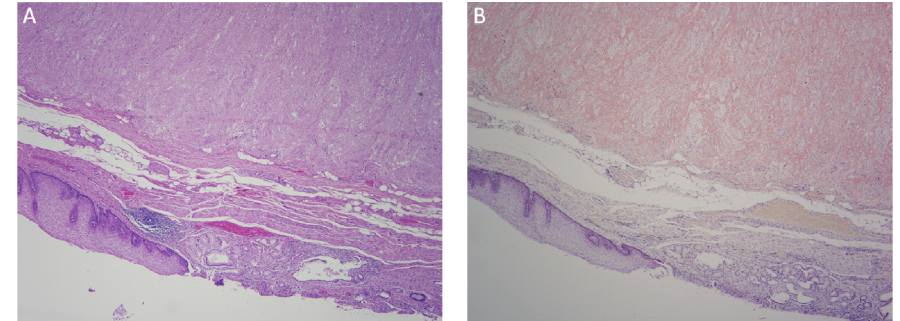
Figure 3: Gastroesophageal junction amyloidosis. (A) Hematoxylin and eosin stain of gastroesophageal junction showing a thickened muscularis propria, 20x. (B) Congo red stain showing diffuse extracellular positive staining (red-orange) restricted to the muscularis propria, 20x.